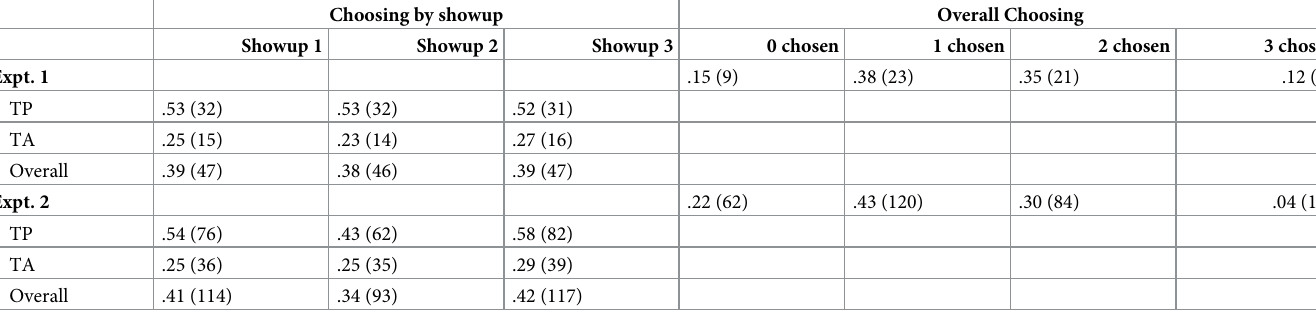
Table 1. Experiments 1 and 2: Proportion (frequency) of choosing across showups and overall.